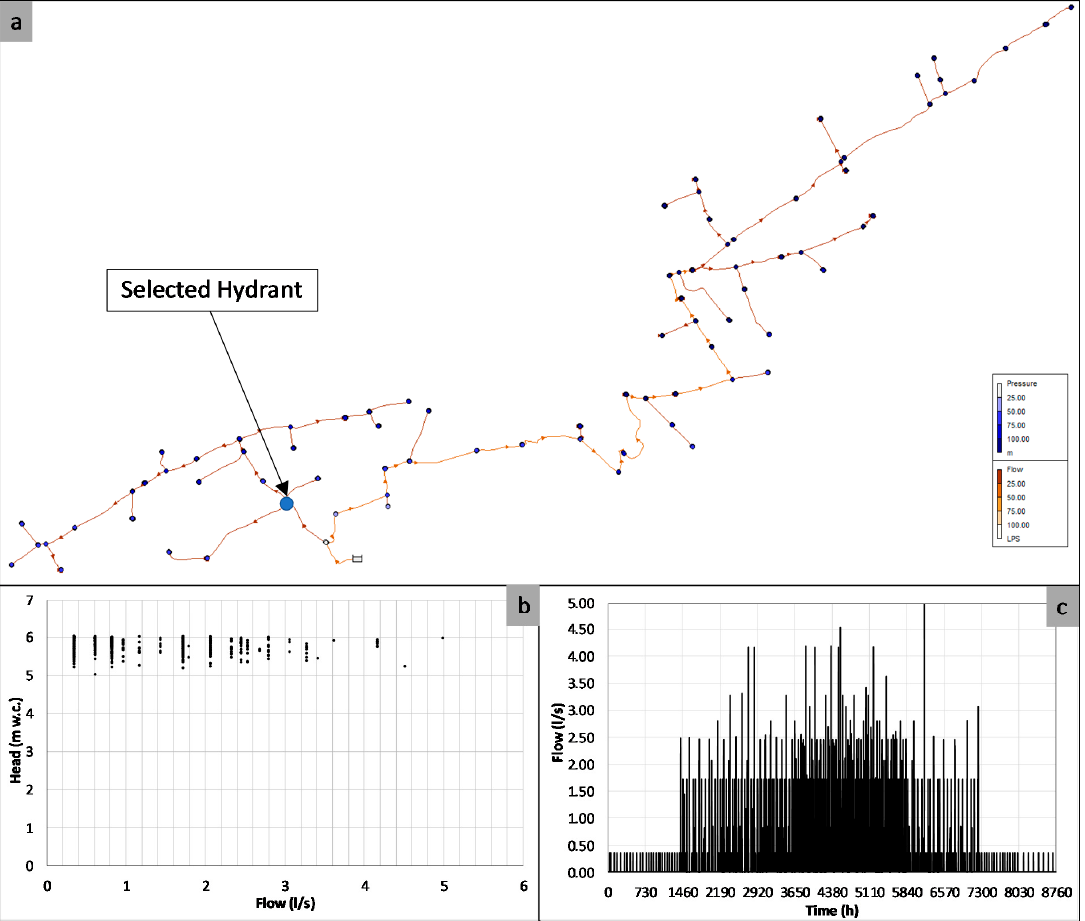
Figure 5. Case study of Vallada: ( a ) the selected irrigation network; ( b ) available head and flow in the selected hydrant; ( c ) flows over time. Table 1. Simulated recovery energy in irrigation